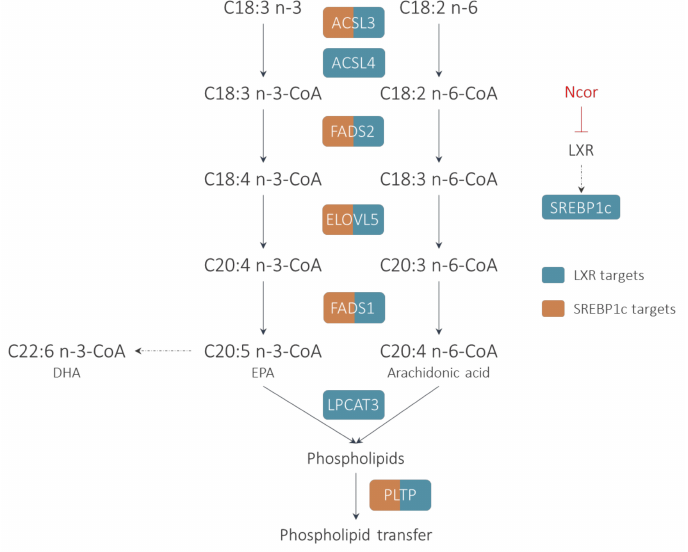
Figure 1. Regulation of polyunsaturated fatty acids (PUFA) synthesis and phospholipid metabolism by liver X receptors (LXRs). PUFA requires the initial activation of the substrate fatty acid into an acyl-CoA by an acyl-CoA synthase (ACSL3 and ACSL4) and the successive actions of delta 5 desaturase (FADS1), elongase (ELOVL5), and delta 6 desaturase (FADS2). LXR regulates directly or indirectly through sterol responsive element binding protein (SREBP) all these classes of enzymes. Interestingly, LXR activation also increases lysophosphatidylcholine acyltransferase (LPCAT3), which promotes the preferential incorporation of eicosapentaenoic acid (EPA) and arachidonic acid (AA) into glycerophospholipids which can be further exchanged by phospholipid transfer protein